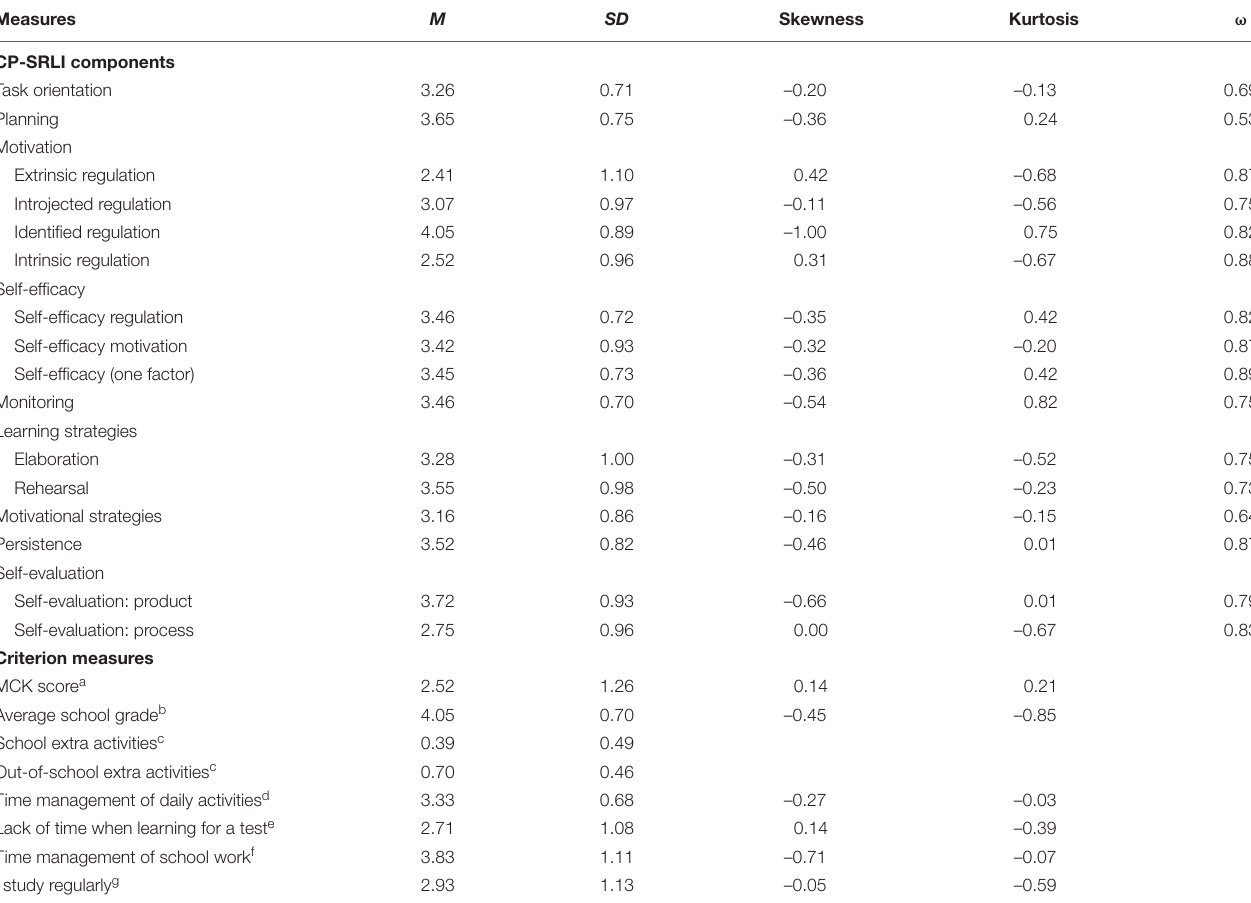
TABLE 2 | Descriptive statistics and McDonald’s omegas for the CP-SRLI components, and descriptive statistics for the criterion measures. Measures M SD Skewness Kurtosis